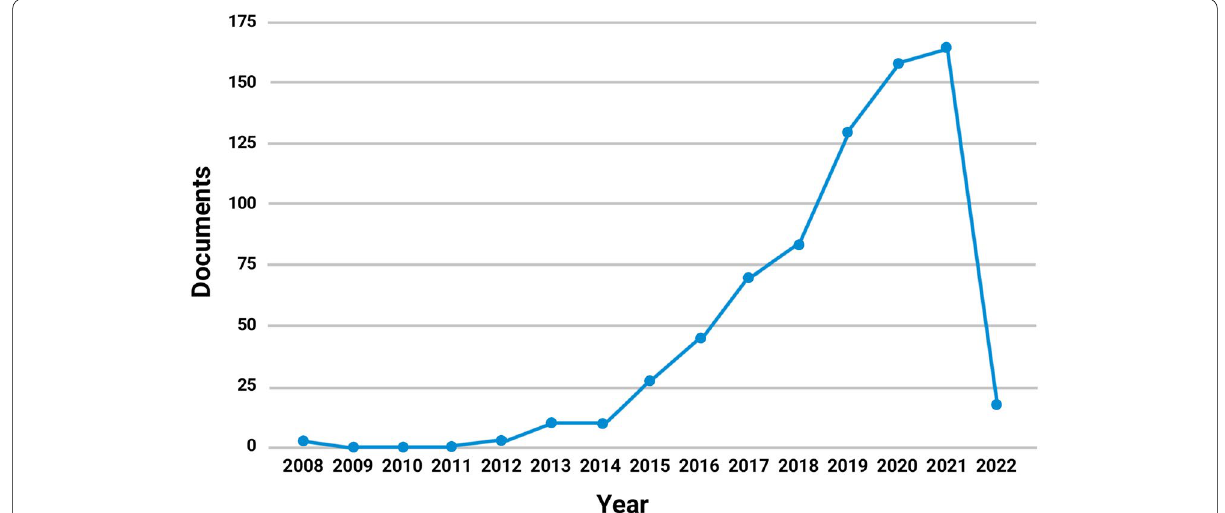
Fig. 2 Number of documents related to ‘smart tourism’ from 2008 to 2022 in the SCOPUS